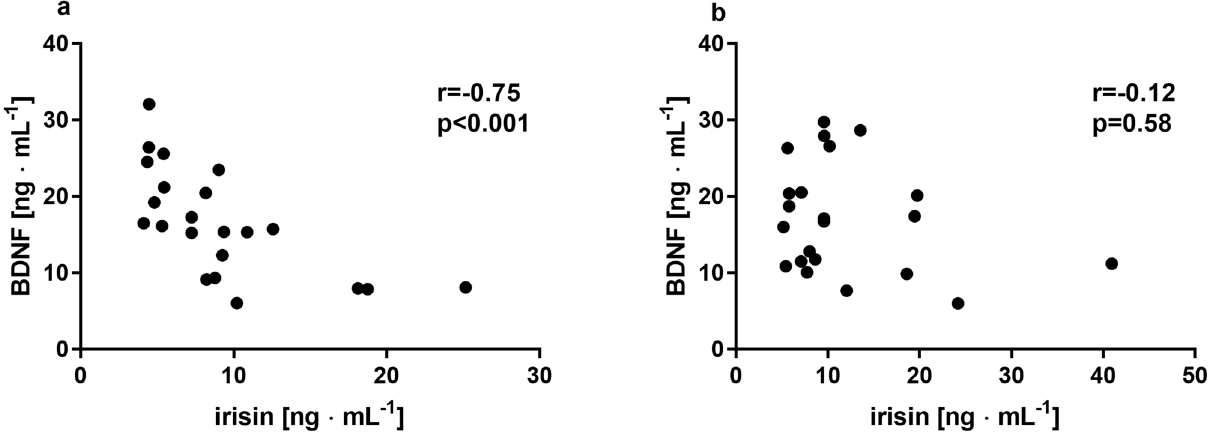
Figure 2. Correlation coefficients between BDNF and irisin in the WBC-EXP (n = 22) group ( a ) prior to and ( b ) after chronic WBC. Values are Spearman correlations, significant at p <